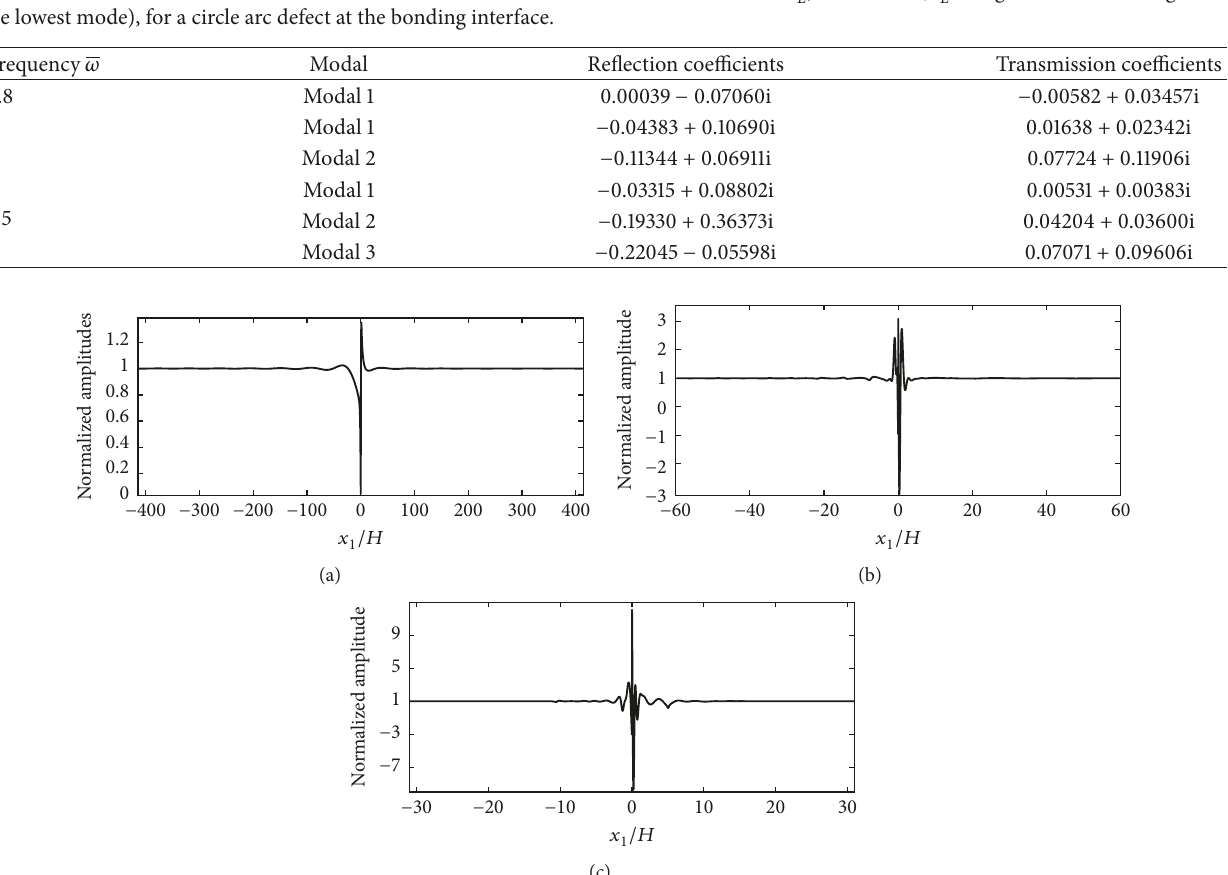
Figure 7: Normalized amplitudes of upper boundary due to a defect at the bonding interface: (a) 𝜔 = 0.8 ; (b) 𝜔 = 5 ; (c) 𝜔 = 9.5 .